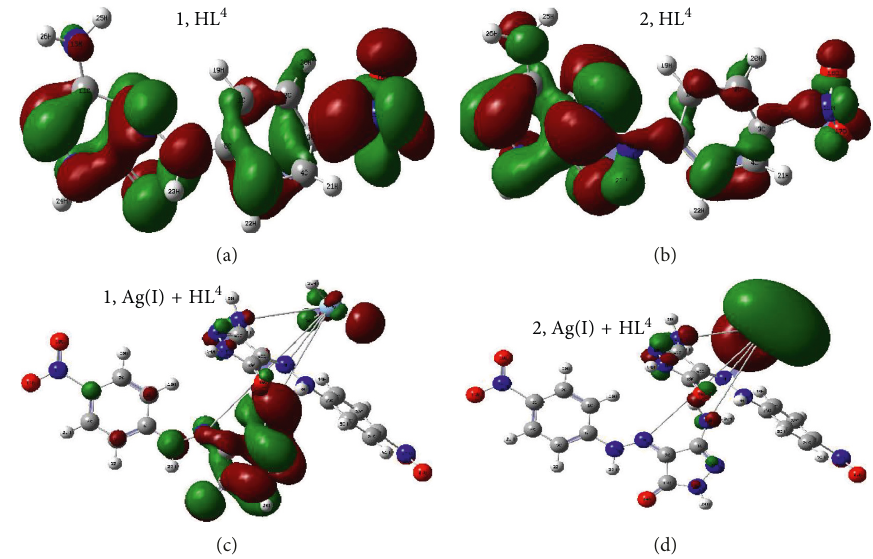
Figure 6: Images of frontier molecular orbital’s (HOMO,1 and LUMO,2) for HL 4 ligand and its Ag(I) complex.